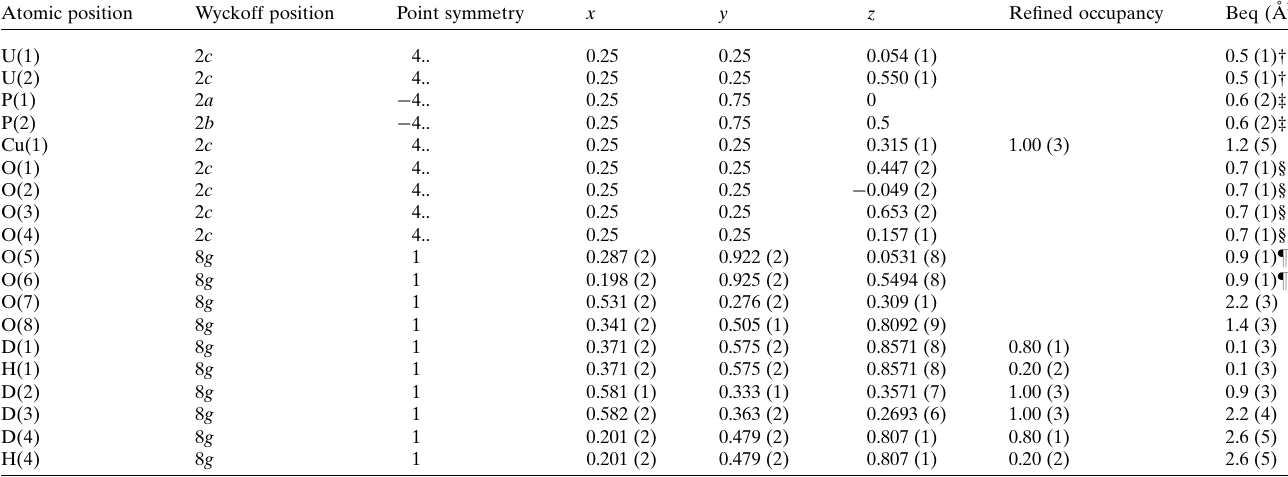
Table 1 Refined atomic coordinates and isotropic thermal displacement parameters for metatorbernite in P 4/ n with unit-cell parameters a = 6.9713 (2) A˚ and c = 17.3219 (7) A˚ .